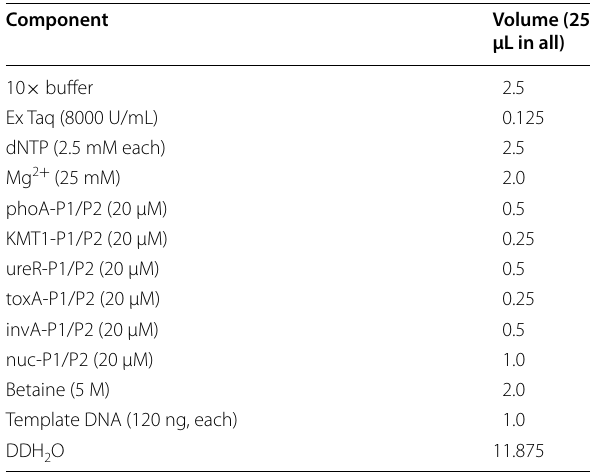
Table 3 Composition of m-PCR